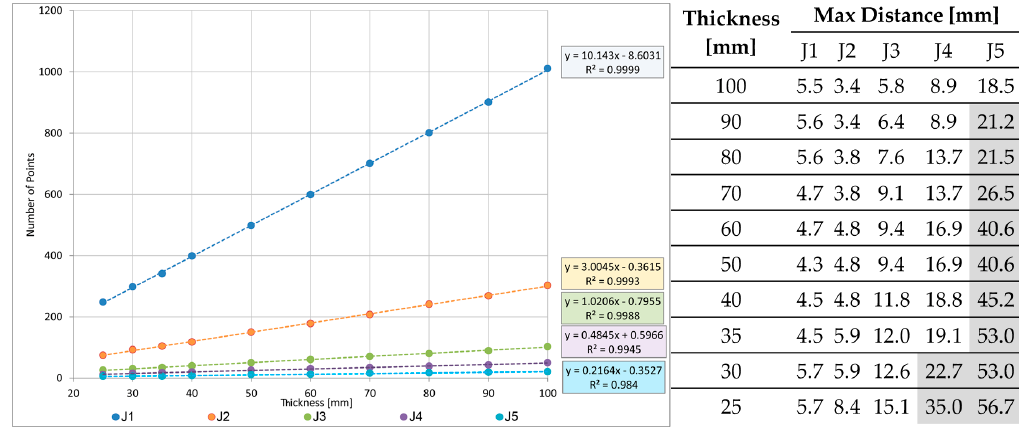
Figure 11. Profiles extracted along the center line. ( a ) profile extracted considering flat the slab surface. ( b ) point cloud (in black) and its linear interpolation for a 150 mm segment as of the joint (in red).